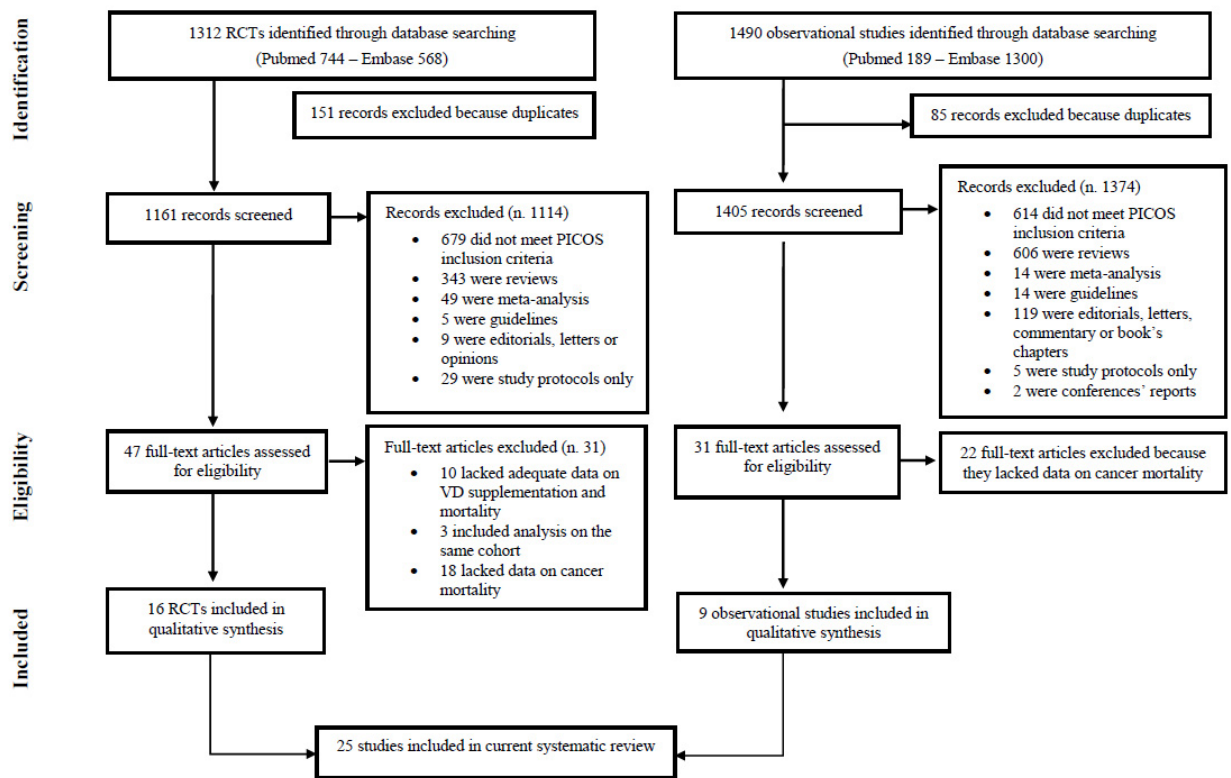
Figure 1. Flowchart of study selection.